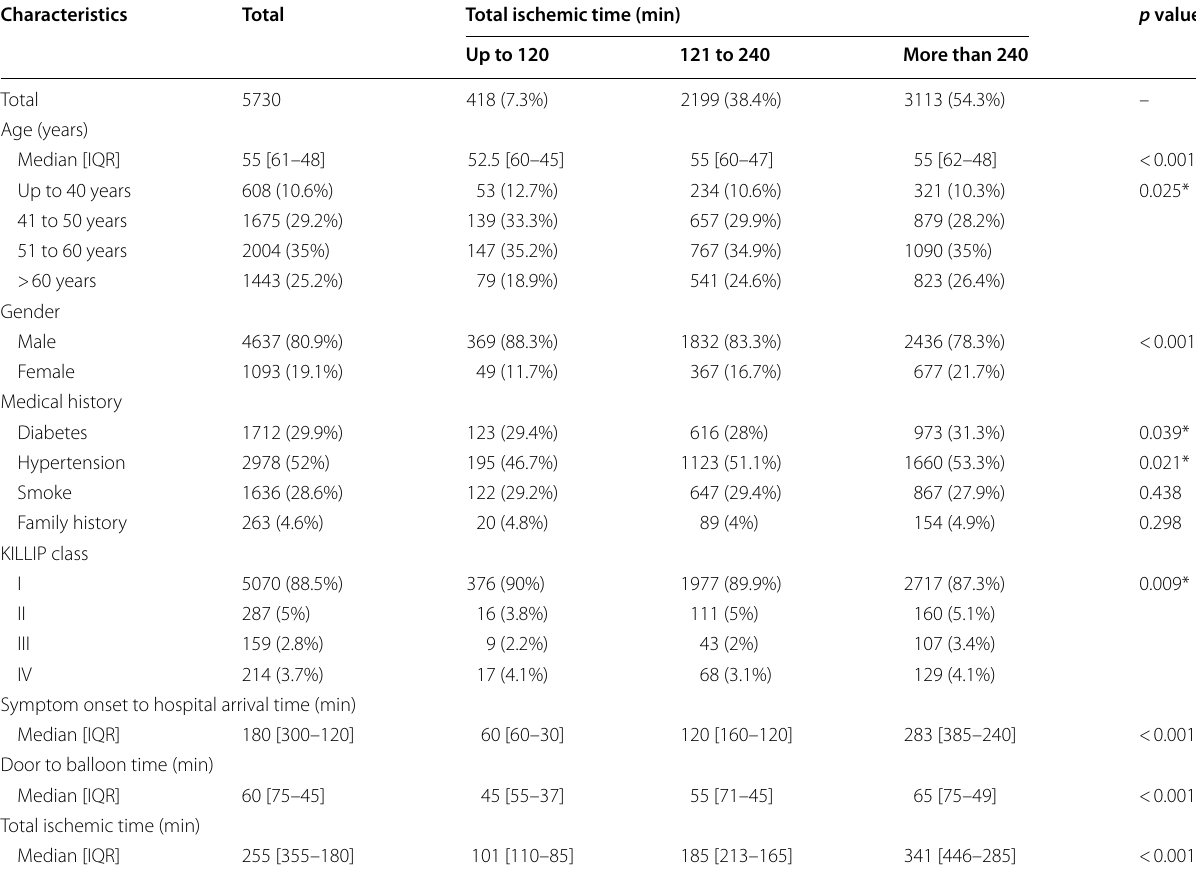
Table 1 Baseline clinical and demographic characteristics stratified by the total ischemic